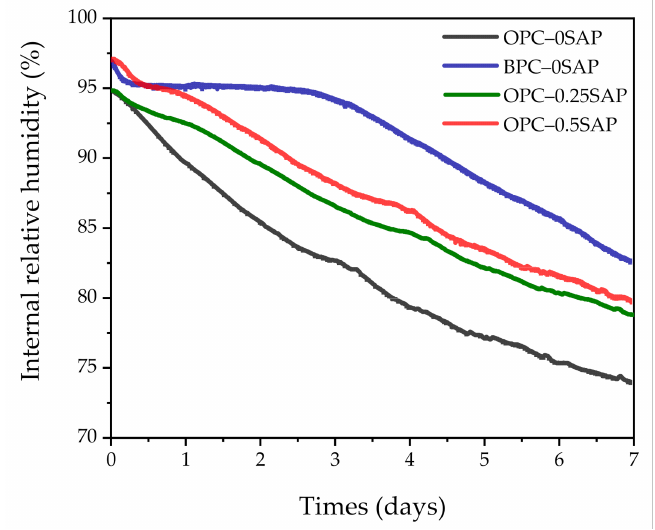
Figure 6. Variation in internal relative humidity with the age of